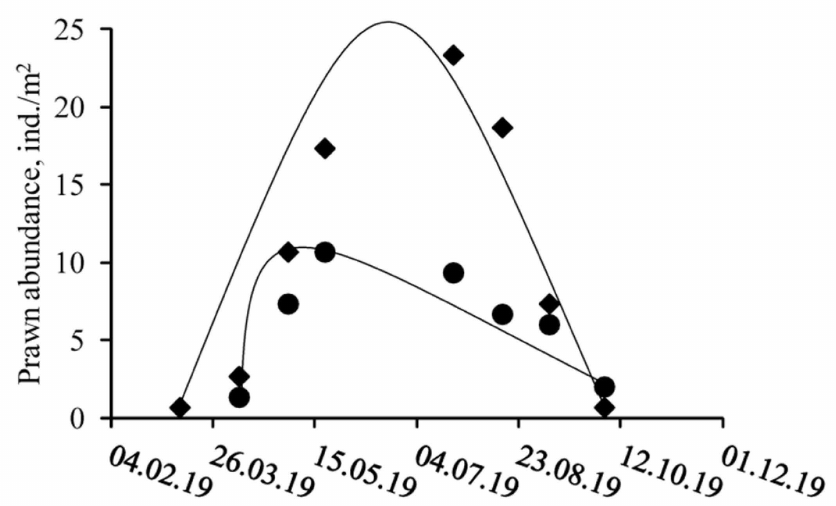
Figure 3. The trends in change of the Palaemon adspersus abundance of males (circles) and females (rhombuses) in the hypersaline Lake Moynaki during